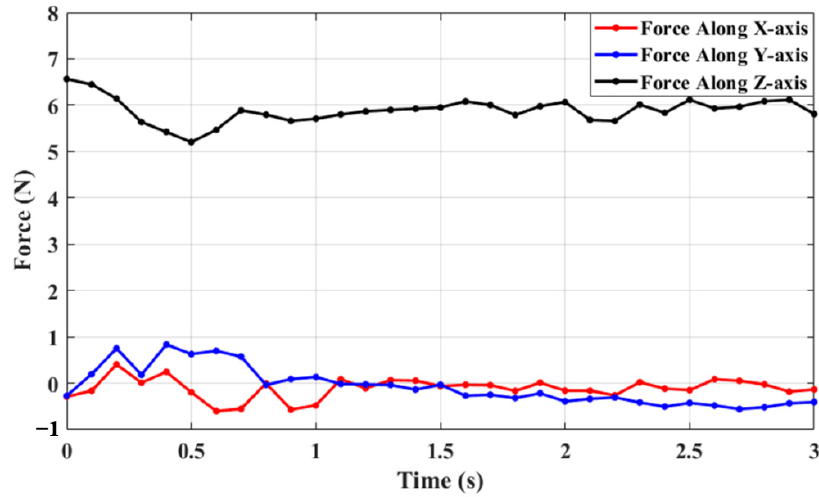
Figure 12. Feedback forces with combined compensation.